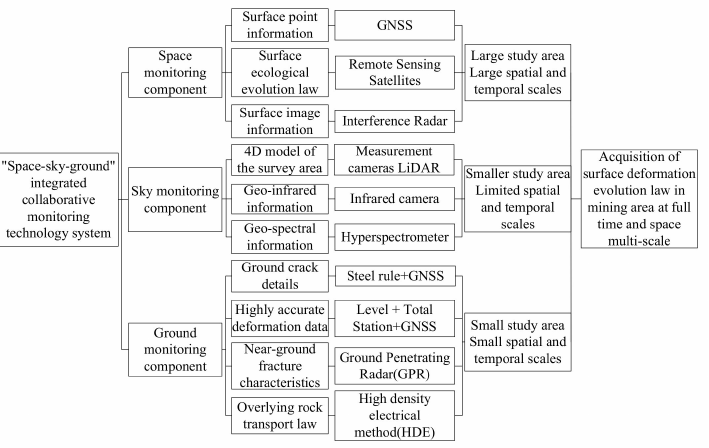
Figure 20. “Space-sky-ground” collaborative monitoring framework for in mining